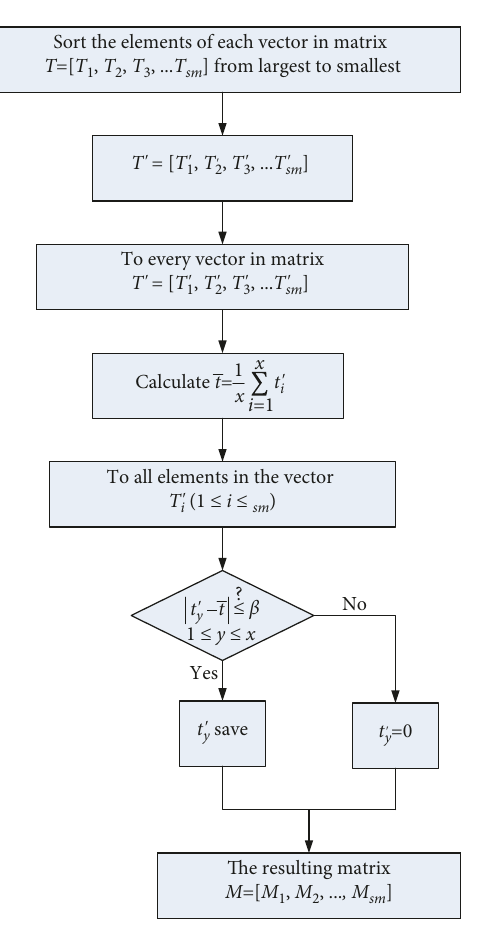
Figure 2: Flowchart for removing low-quality data.